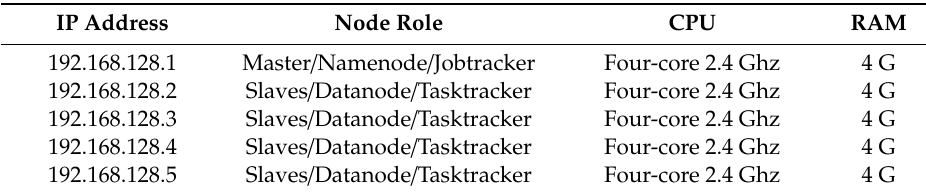
Table 4. Hadoop experiment environment.